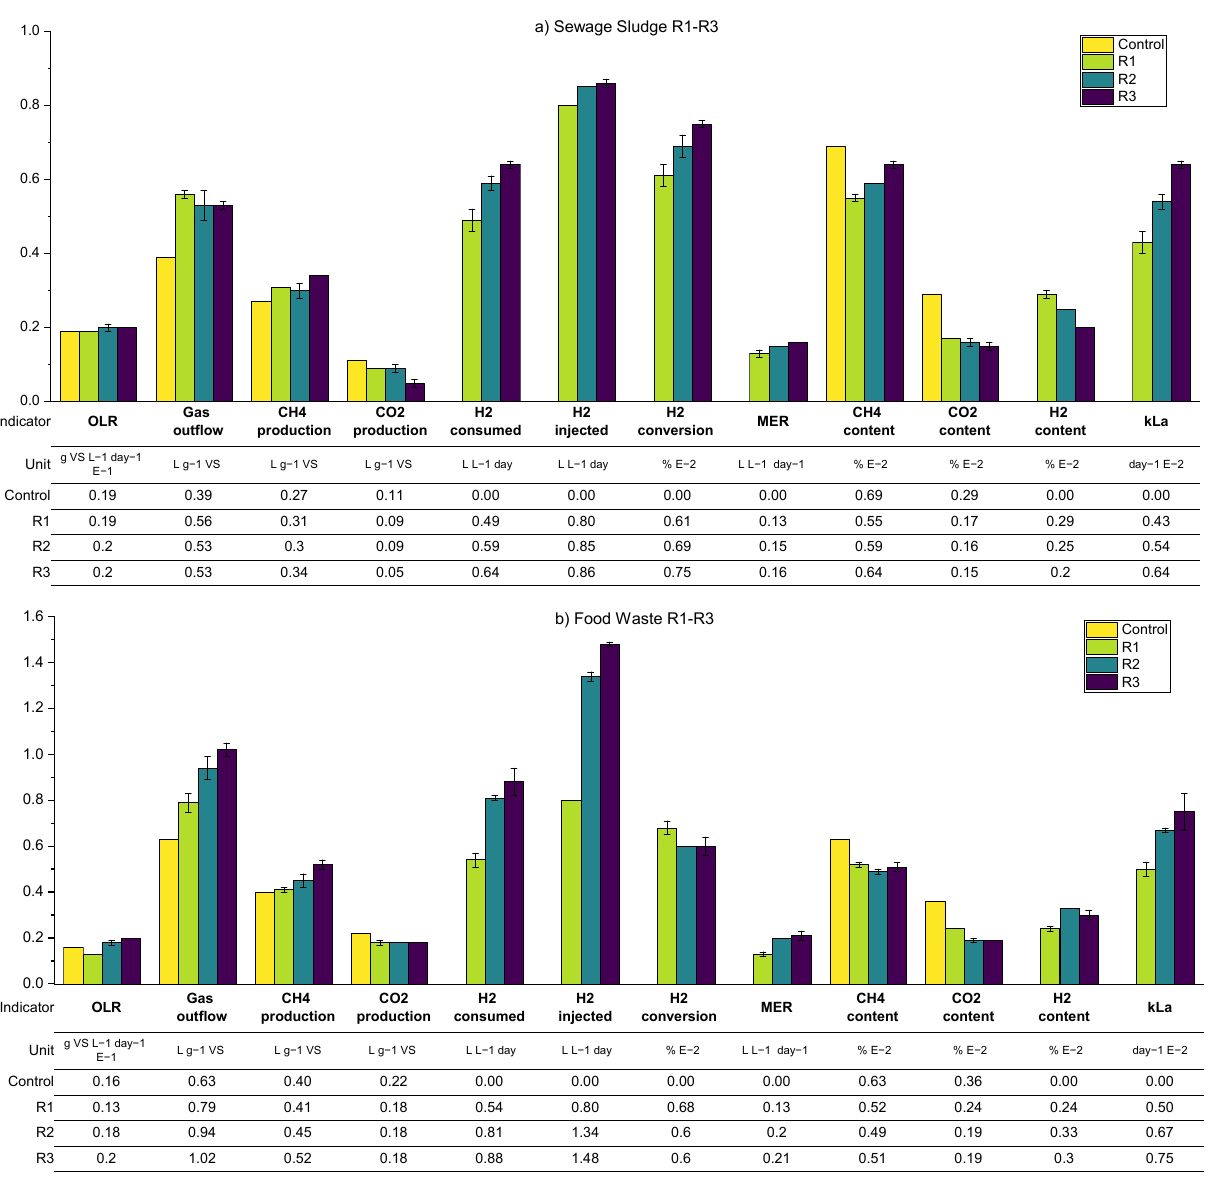
Figure 10. Summarised biomethanation experimental results; periods R1–R3 using SS ( a ) and FW ( b ). Error bars show duplicate reactor averages, and E notation is used to scale results to the same vertical axis.